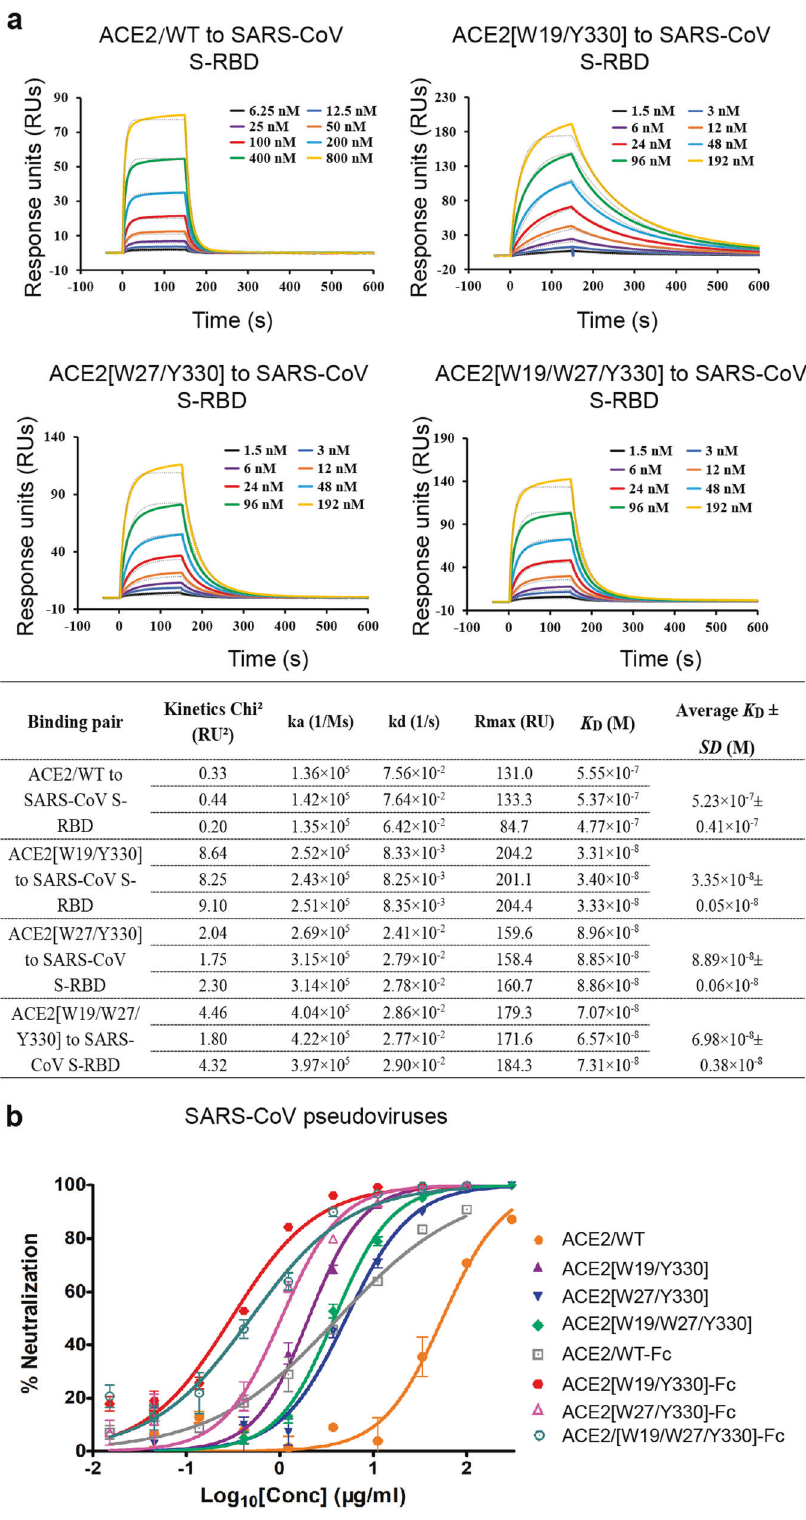
Fig. 6 Enhanced SARS-CoV S-RBD binding and increased virus entry-inhibition associated with the ACE2 mutations. a An SPR assay characterizing the real-time binding kinetics of the ACE2 proteins (wild-type and mutants) to SARS-CoV S-RBD. Three independent experiments are conducted and the recorded pro fi les from one representative experiment are shown. The calculated kinetic parameters are summarized. b Increased inhibitory ef fi cacy of the indicated ACE2 mutants in blocking virus entry of SARS-CoV. The luciferase-incorporated SARS-CoV pseudovirus is pre-incubated with the indicated ACE2 proteins (wild-type and mutants) for 1 h at 37 °C and then used to infect the human ACE2-transfecting 293T cells. Luciferase activities in target are measured. Each point represents the mean ± SD from triplicate experiments